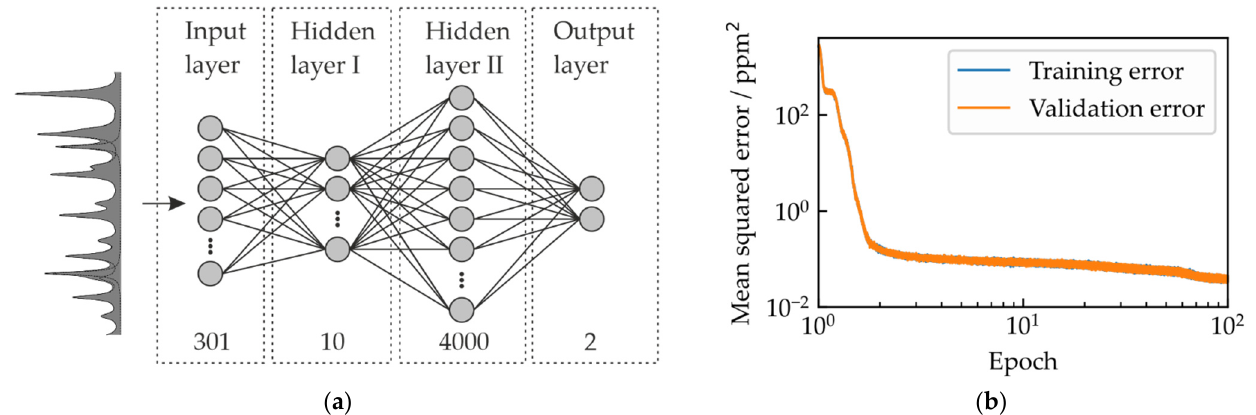
Figure 3. Artificial neural network architecture and training results. ( a ) The spectrum with 301 spectral points is put into the first network layer, whose number of nodes corresponds to the number of spectral points. The network consists of two hidden layers with 10 and 4000 nodes for the first and second layer, respectively. The network is trained to provide the gas concentrations in units of parts per million (ppm) in the output layer; ( b ) Evolution of the mean squared error while network training for the training and the validation dataset. The number of epochs is defined by the number of iterations on the entire training dataset, which contains 10 7 labeled synthetically generated spectra.